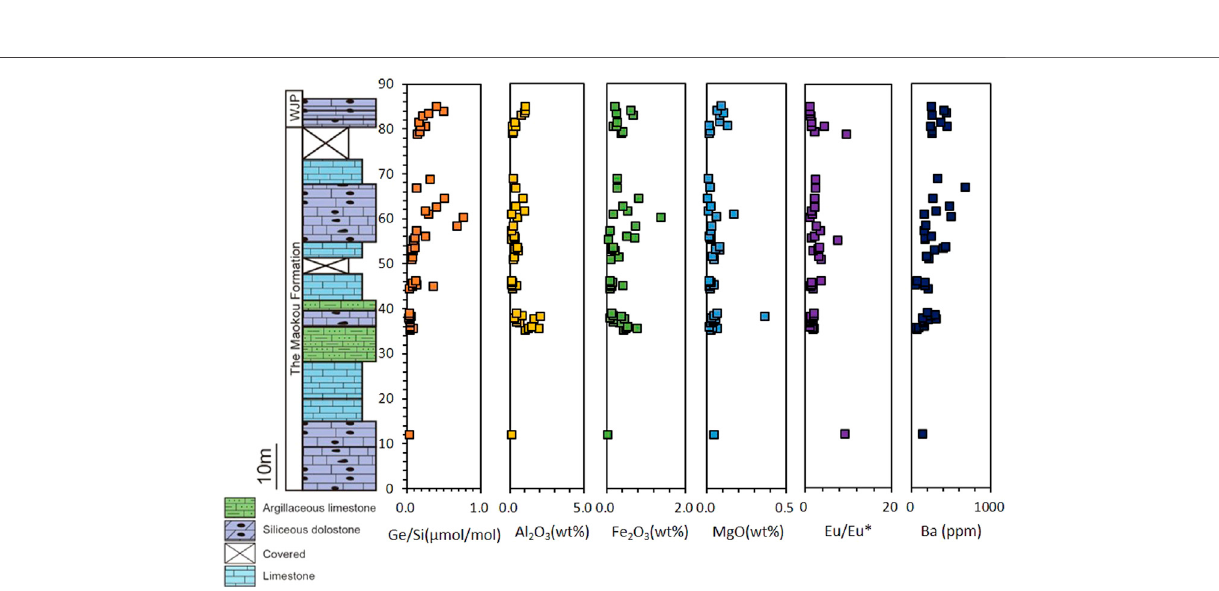
Frontiers in Earth Science |